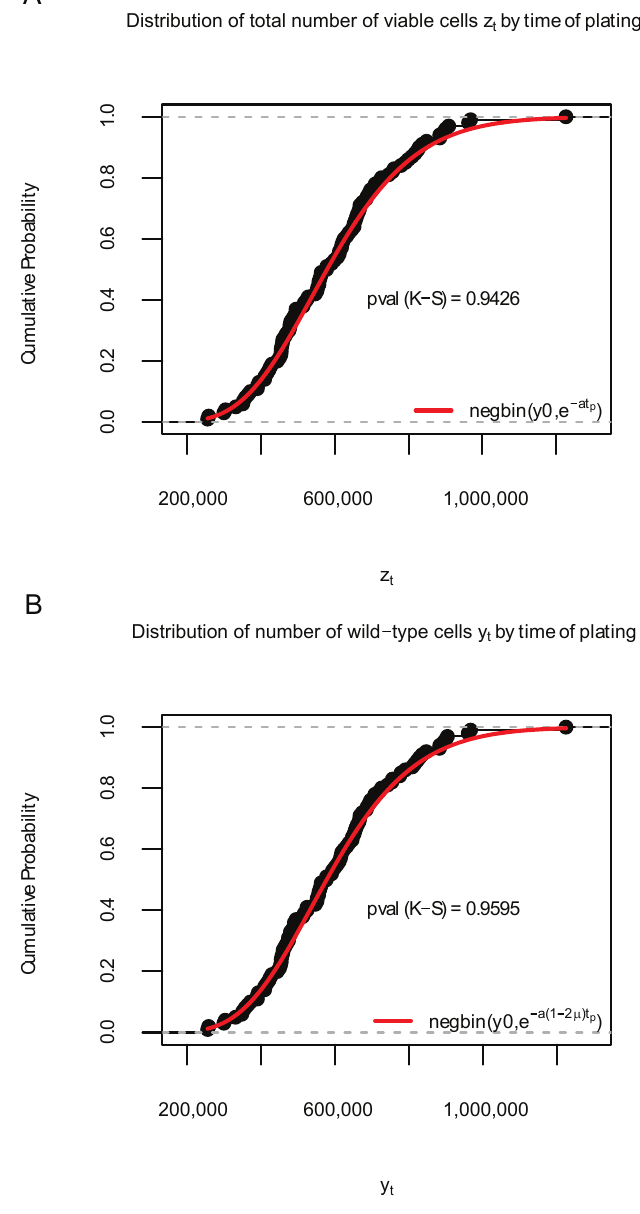
Figure 4. Distribution of 100 data samples generated by SimuBP in Simulation S1b. ( A ): Empirical cumulative distribution function (ECDF) of the total number of viable cells z t when the time of plating t p = 11. ( B ): ECDF of the number of wild-type cells y t when t p = 11. The red curves represent the cumulative distribution function of the theoretical negative binomial distributions in